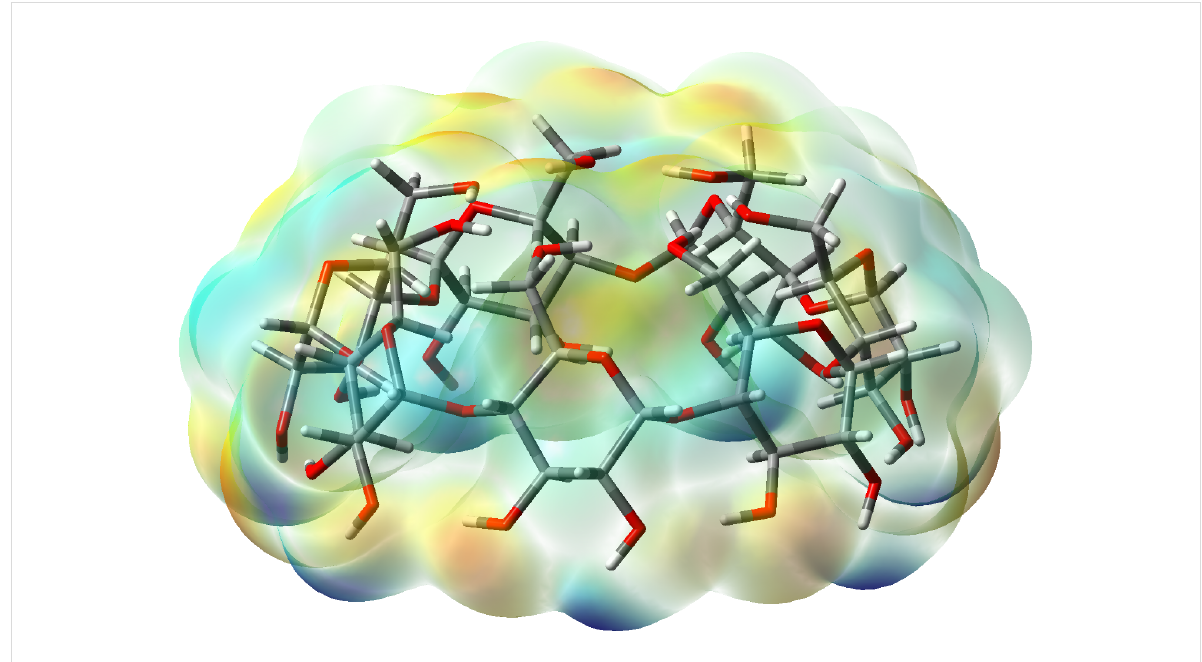
Figure 4: Graphical model of the β -CD electron density (isovalue = 0.002), mapped with electrostatic potential (color scheme used: blue for the posi- tive surface map values and red/yellow for negative ones).